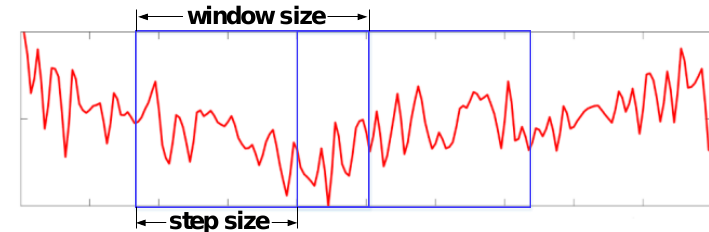
Figure 15. Segmentation for subcarriers using a fixed window and step size.